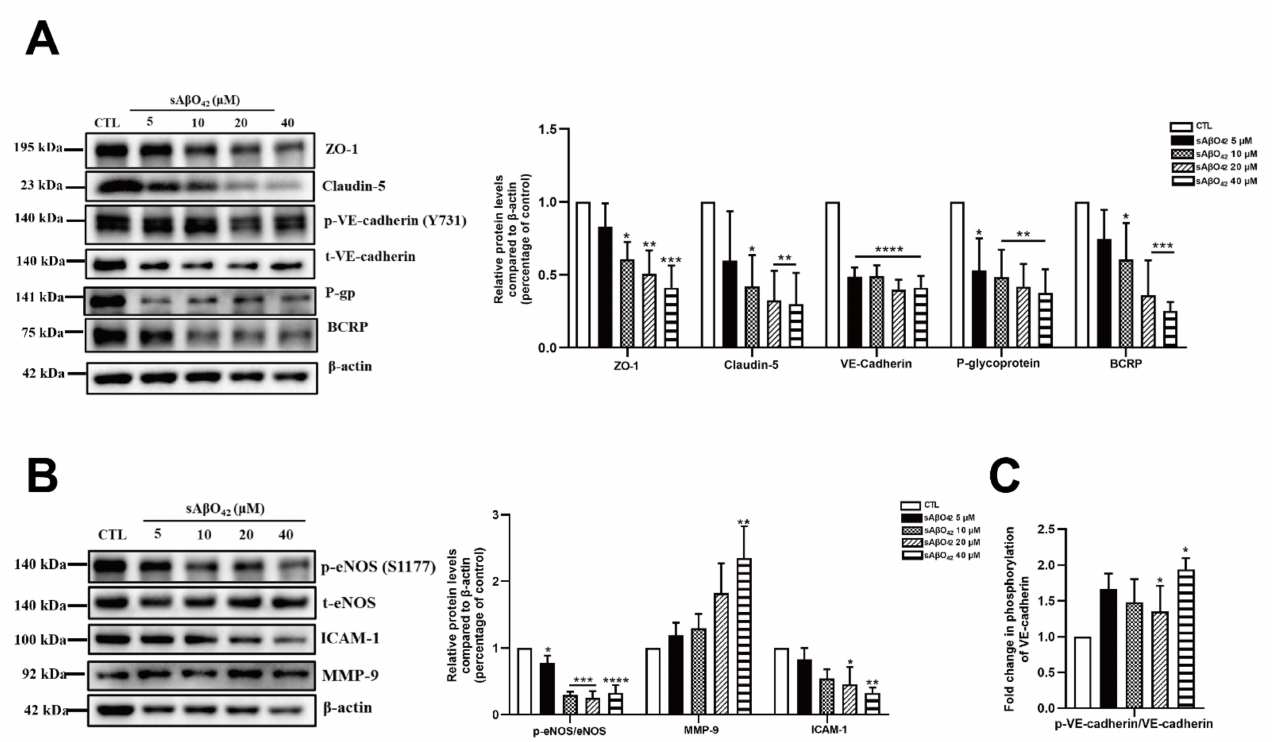
Figure 3. Murine sA β O42 altered the protein levels and activities of constitutively expressed endothe- lial proteins in the bEnd.3 monolayer. The protein expression levels of junctional proteins ( A ) ZO-1, claudin-5, VE-cadherin, and BBB transporters P-glycoprotein (P-gp) and breast cancer resistance protein (BCRP), as measured by western blot. ( B ) The ratio of phosphorylated endothelial nitric oxide synthase (eNOS)/total eNOS, and the protein expression levels of matrix metallopeptidase 9 (MMP-9) and basal intercellular adhesion molecule 1 (ICAM-1). ( C ) The ratio of phosphorylated endothelial VE-cadherin/VE-cadherin. Data are shown as means ± SD of at least three independent experiments and were analyzed by one-way ANOVA followed by a post hoc Dunnett’s test. * p ≤ 0.1, ** p ≤ 0.01, *** p ≤ 0.001, **** p ≤ 0.0001 vs. control